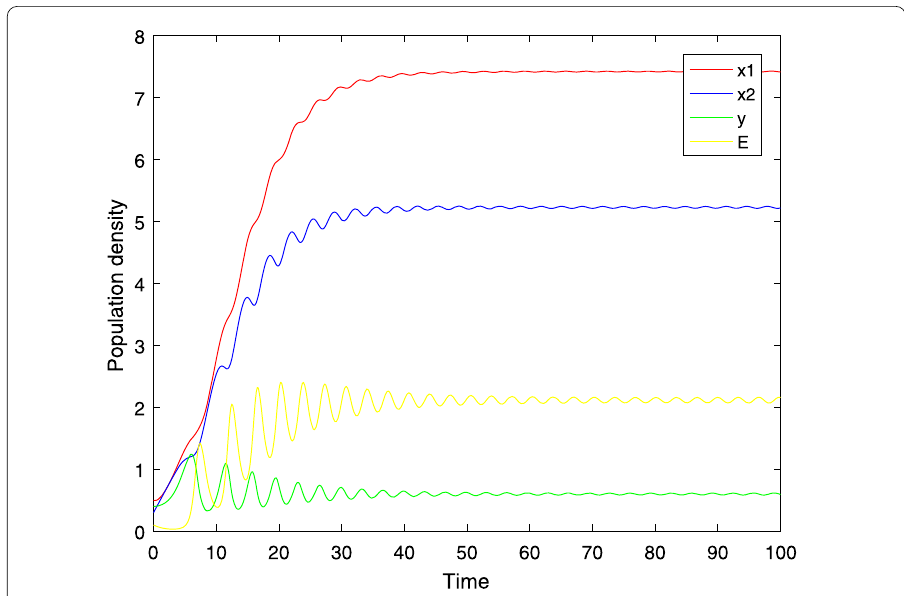
Figure 6 The state response of system (17) with m = 0.02 at P ∗ . The state response of system (17) with m = 0.02 at P ∗ .